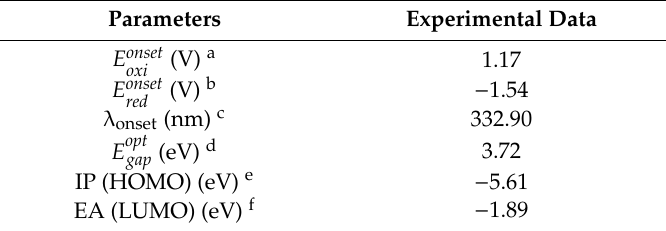
Table 1. Electrochemical and electronic properties of spiropyran 7 .